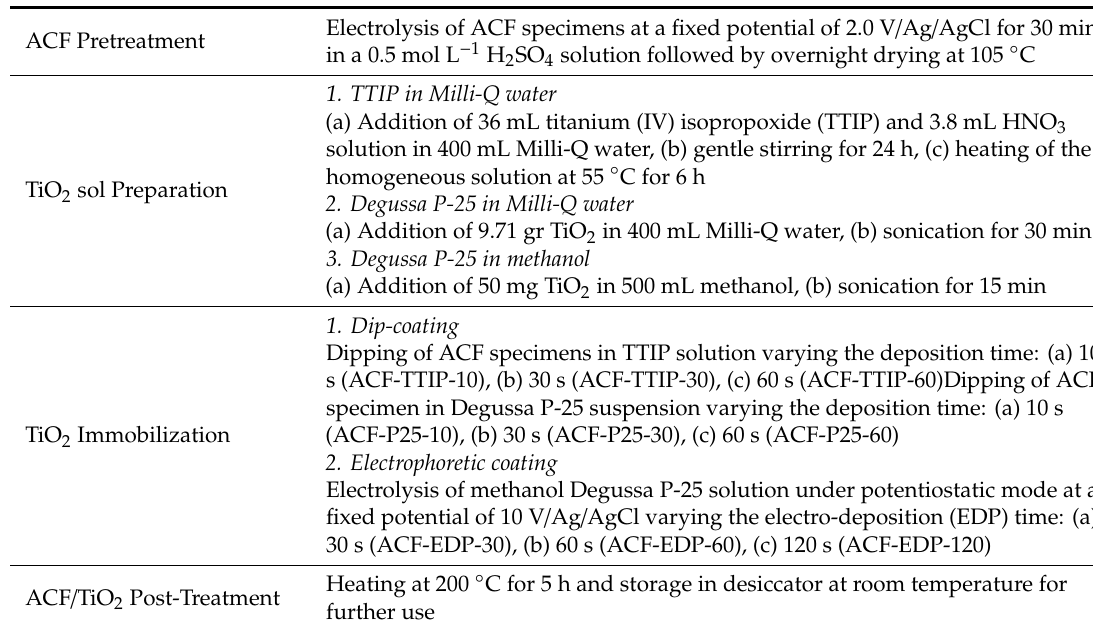
Table 2. Protocol of TiO 2 immobilization on ACF according to electrophoretic coating and dip-coating